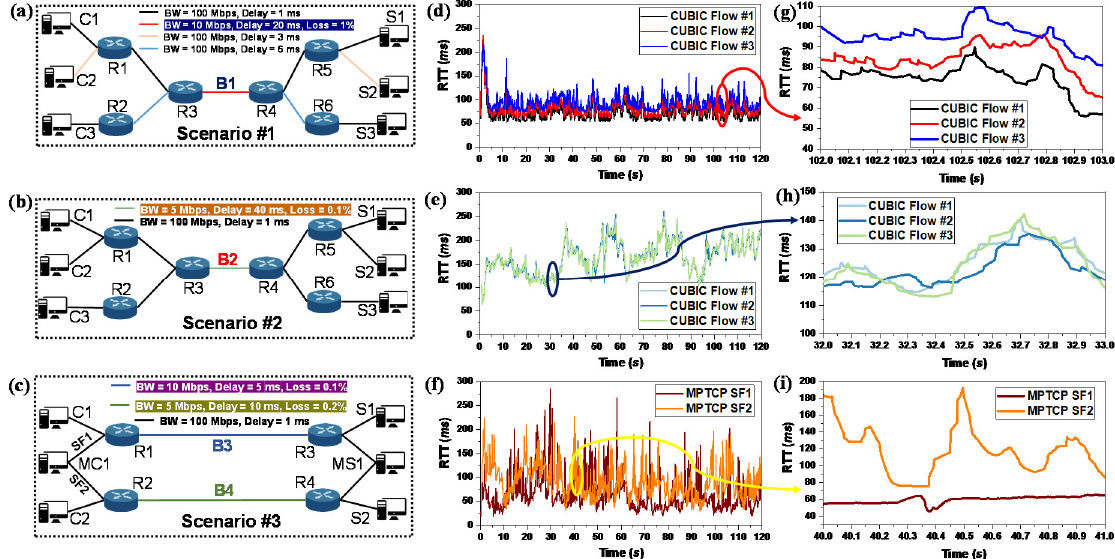
Figure 2. A simple experimental analysis to observe the relationship between RTT and SB; ( a – c ) Scenarios #1–3; ( d – f ) RTT for Scenarios #1–3; and ( g – i ) the magnified version of RTT for Scenarios #1–3 for the period between 102–103 s, 32–33 s, and 40–41 s, respectively.